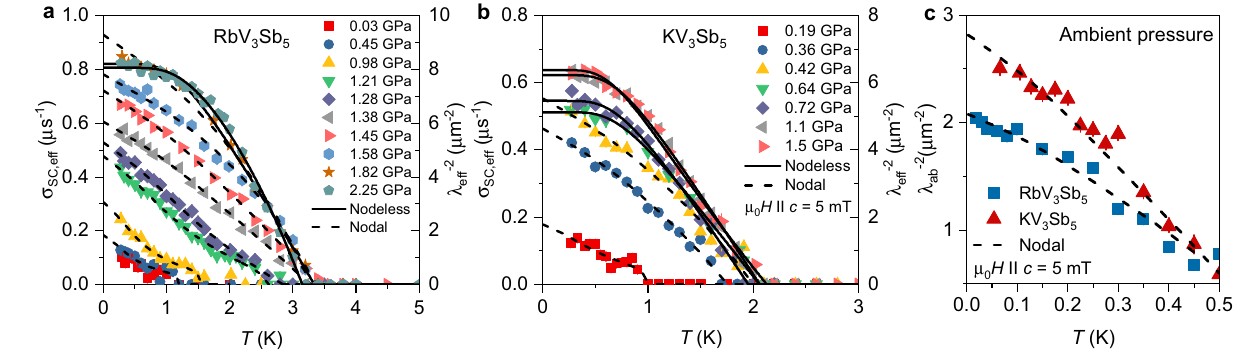
Fig.4|Tunablenodalkagomesuperconductivity. Thetemperaturedependence of the superconducting muon spin depolarization rates σ sc for RbV 3 Sb 5 ( a ) and KV 3 Sb 5 ( b ), measured in an applied magnetic fi eld of μ 0 H =5mT at ambient and various applied hydrostatic pressures. The error bars represent the standard